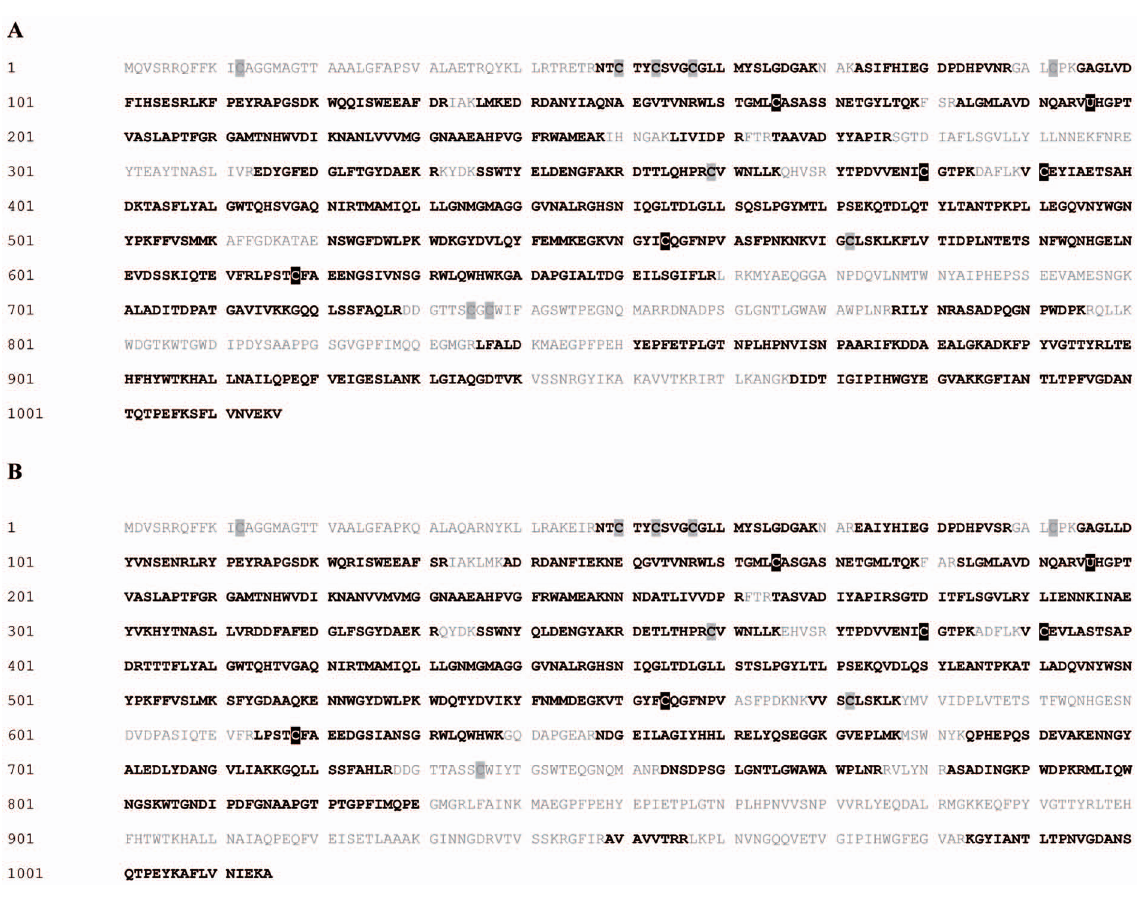
Figure 4. Amino acid sequences of (A) FdoG and (B) FdnG. Peptides identified by MS/MS analysis are shown in bold, while sequences that were not covered by MS analysis are shown in grey. Cysteines are shown in grey boxes, selenocysteines and dehydroalanines are shown in black boxes. Sec-196 (U) is the specific selenocysteine amino acid inserted by decoding of the UGA codon. (A) Sequence coverage of FdoG is 70.5%, selenocysteine substitutions were identified at positions 165, 380, 391, 554, and 618. (B) Sequence coverage of FdnG is 77.0%, selenocysteine substitutions were identified at positions 165, 380, 391, 554, and 618.